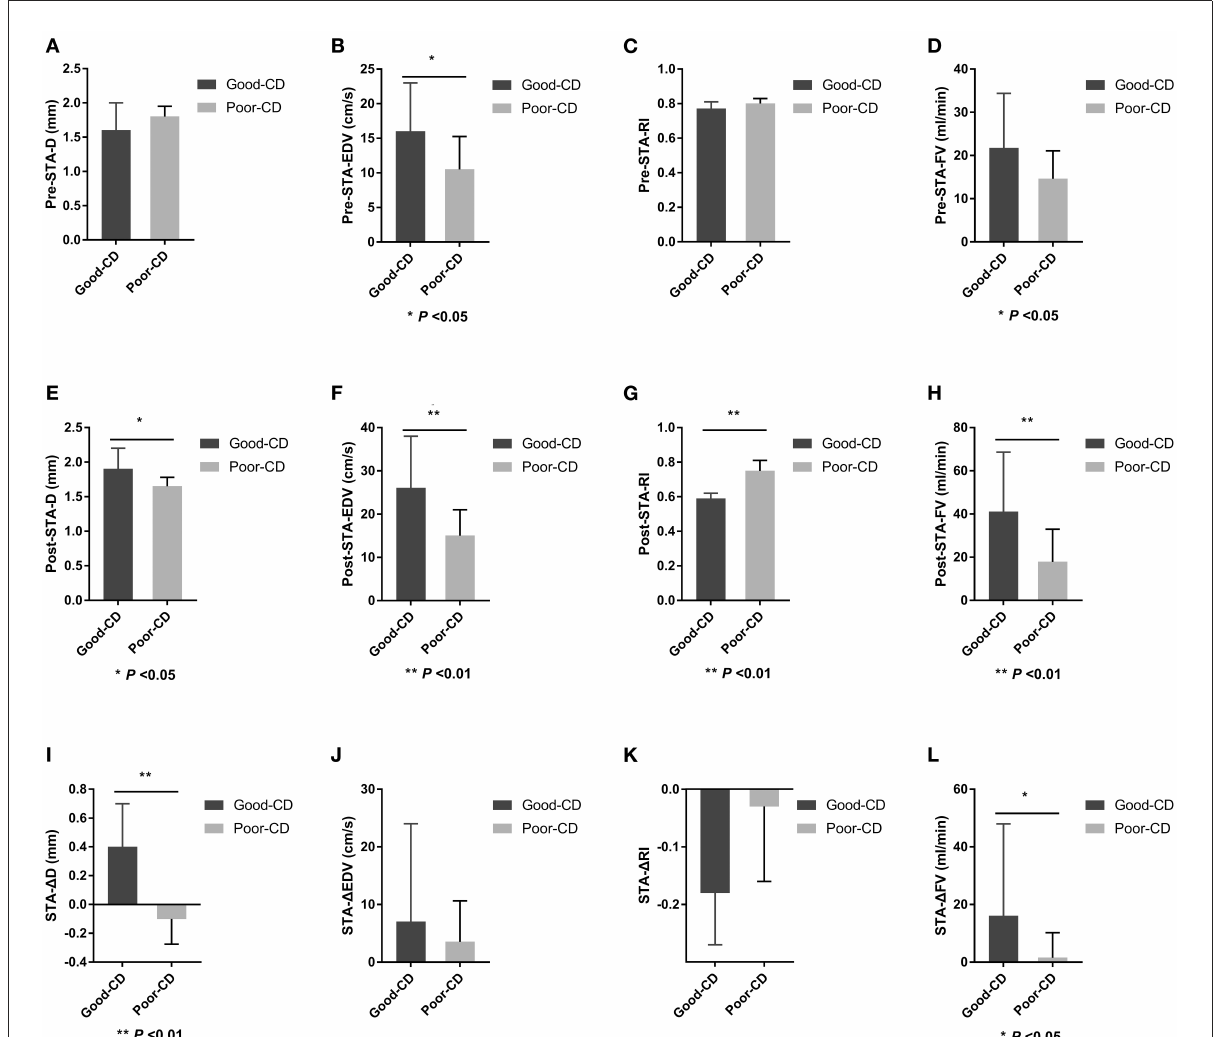
FIGURE7 Differences in STA ultrasound parameters between good and poor collateral development groups after EDAS. STA, superficial temporal artery; EDAS, encephalo-duro-arterio-synangiosis; D, inner diameter; CD, collateral development; EDV, end-diastolic velocity; RI, resistance index; FV, flow volume; 1 , the difference between postoperative and preoperative parameters.